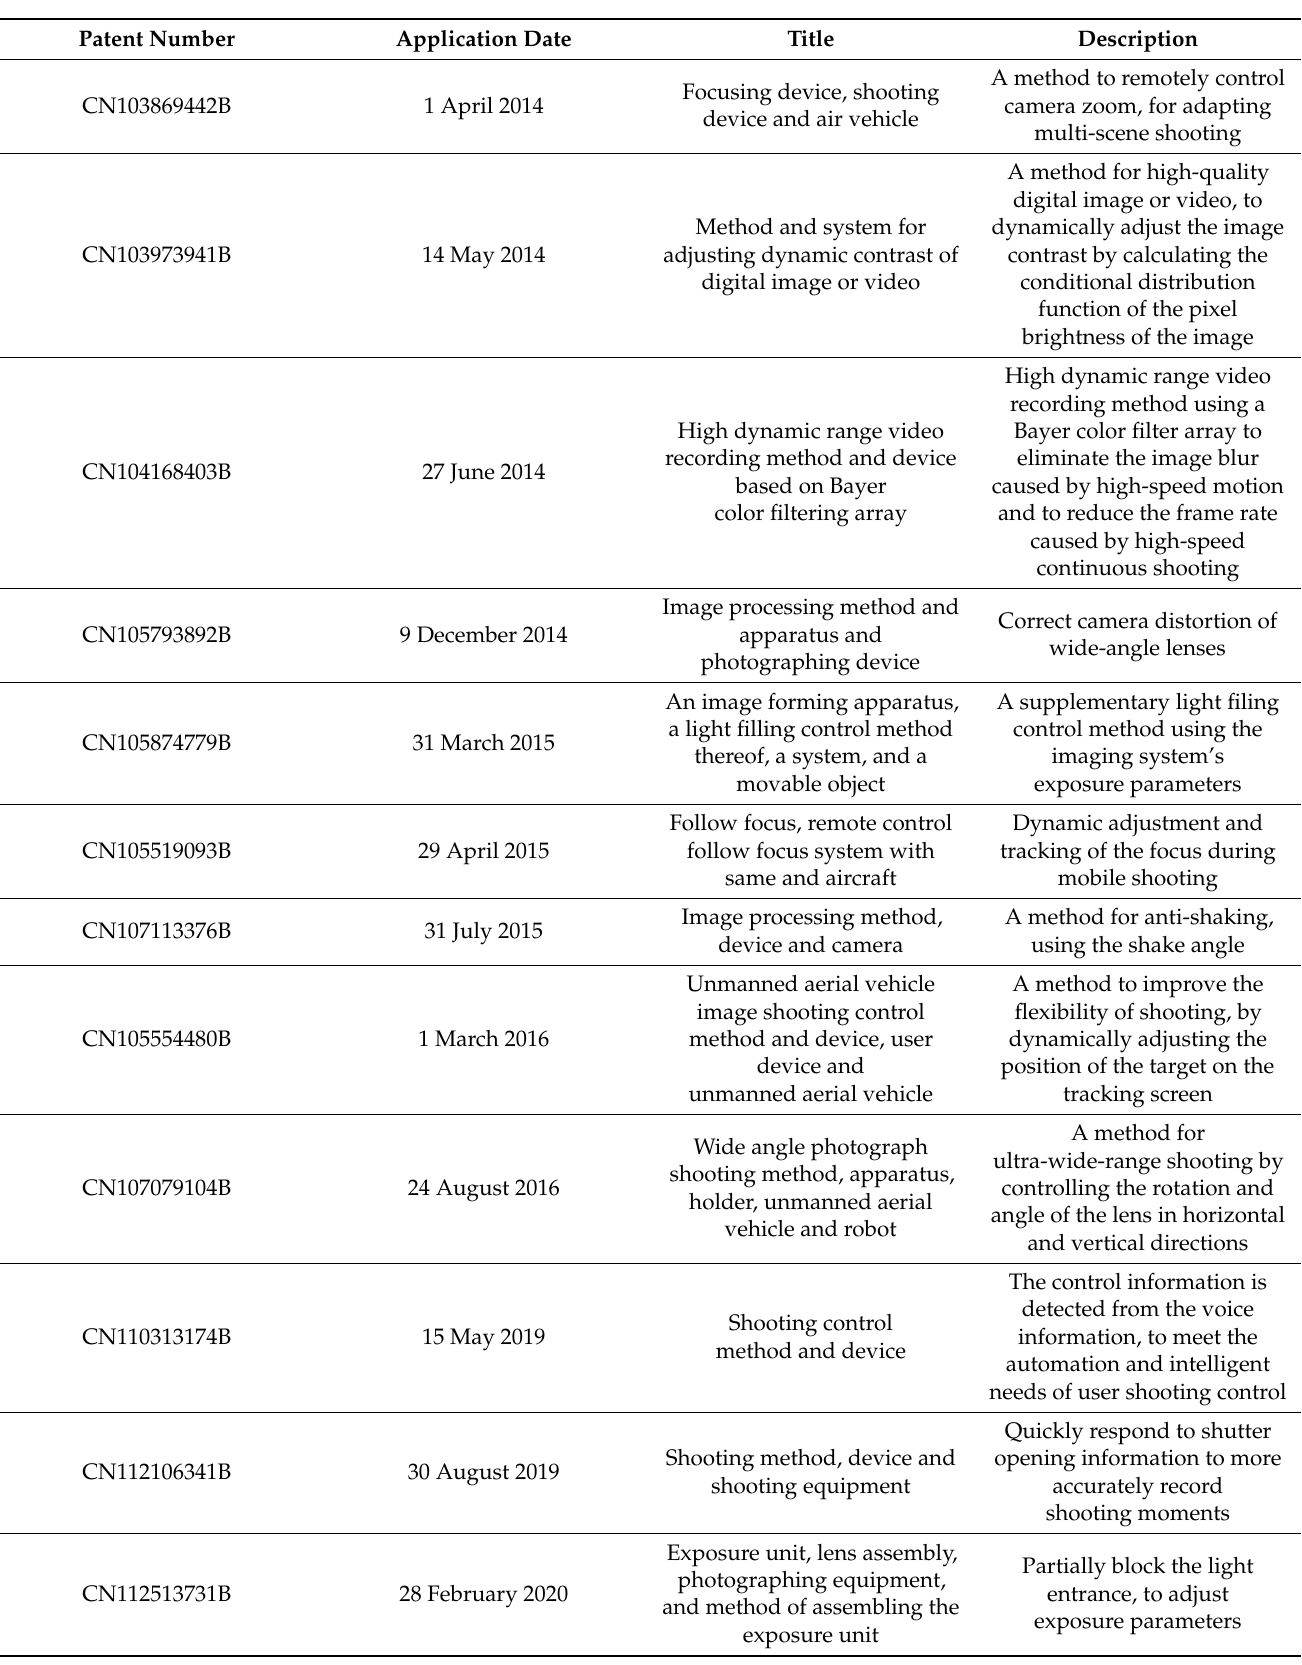
Table 6. Patents with radical invention features in the executive system of